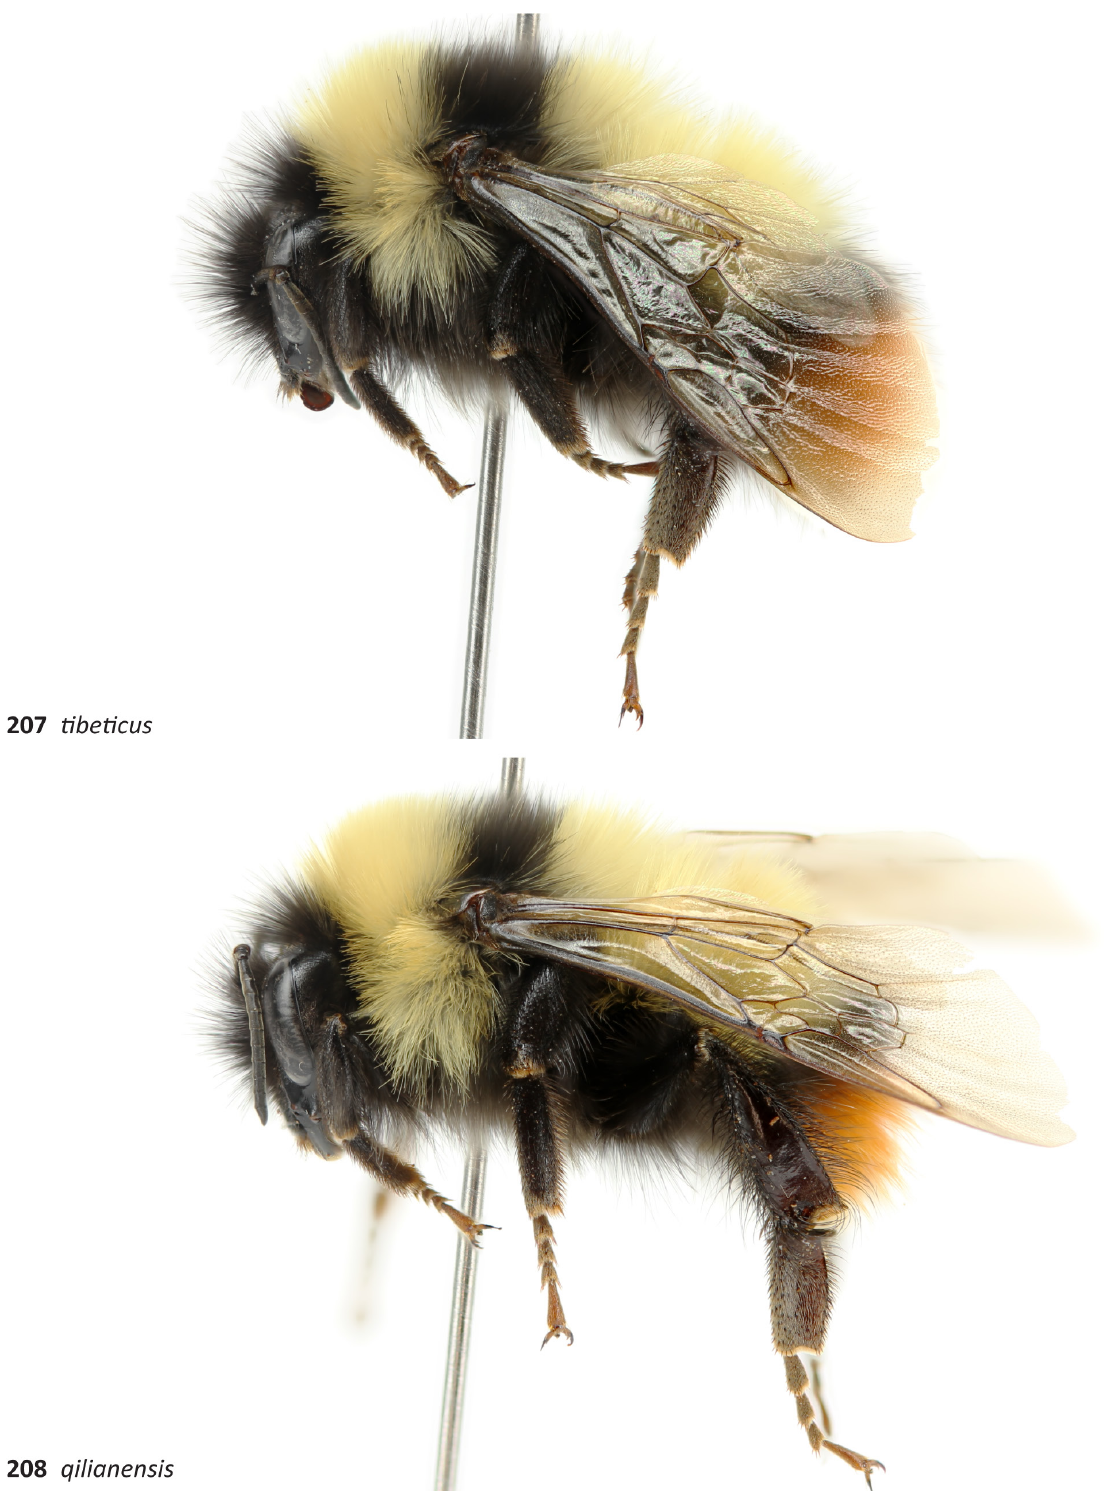
Figs 207–208. Images of holotype workers of two new cryptic species from around the eastern Qinghai- Tibetan plateau. 207 . Bombus tibeticus sp. nov. from near the Kunlun pass (3970 m a.s.l.) in the Kunlun mountains (ML228). 208 . B. qilianensis sp. nov. from Qushiang (3370 m a.s.l.) in the Burhan Budai mountains (ML306). Viewed from the left lateral